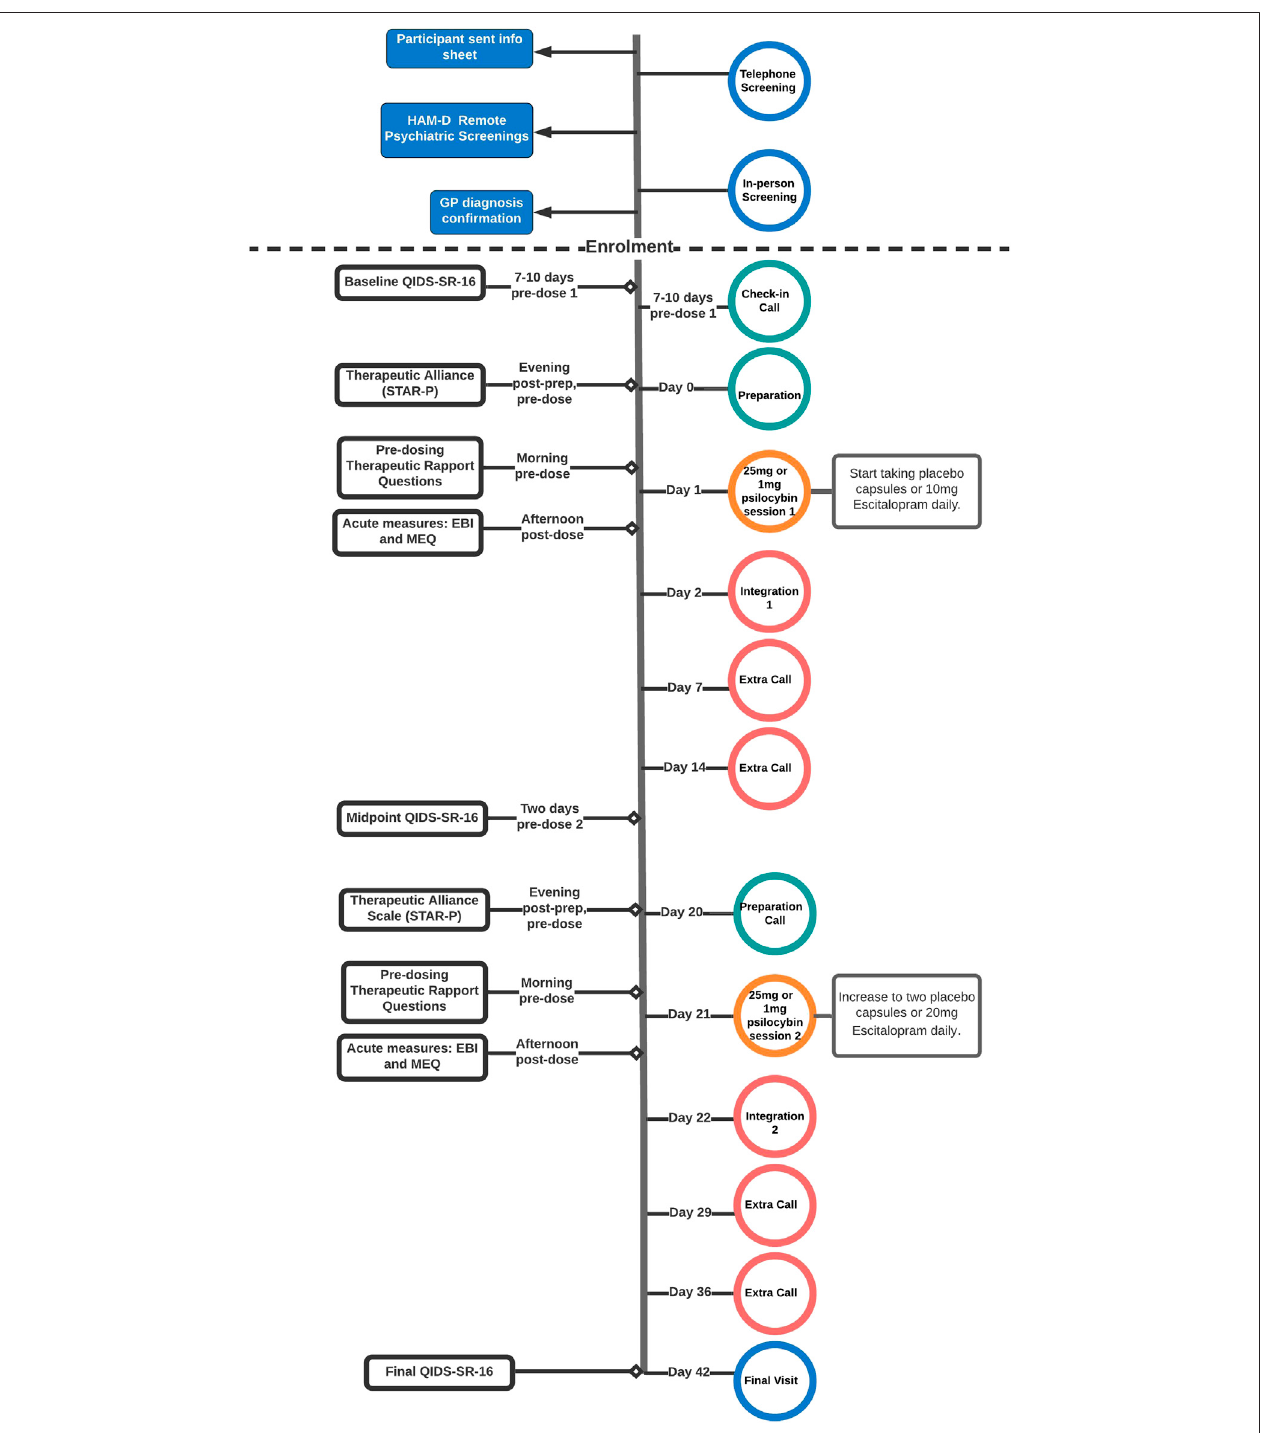
FIGURE 1 | Flow-chart outlining study procedures for the psilocybin and escitalopram arms of the trial featured in this article, outlined in “ Design and Procedures ” . All participants included in this analysis followed the outlined procedures, unless otherwise stated in the “ Descriptives ” section of the results. After the 6-weeks key endpoint, participants completed remote monthly follow-up assessments until 6 months post-study. The dotted line separates pre-enrolment screening procedures (above line) from post-enrolment study procedures (below line). Info Sheet: Participant Information Sheet, HAM-D: 17-item Hamilton Depression Scale (clinician- rated),GP:GeneralPractitioner,STAR-P:ScaleToAssesstheTherapeuticRelationship(participant-ratedversion),QIDS-SR-16:16-itemSelf-ReportedQuickInventory of Depressive Symptomatology (primary outcome), EBI: Emotional Breakthrough Inventory, MEQ: Mystical Experience Questionnaire.